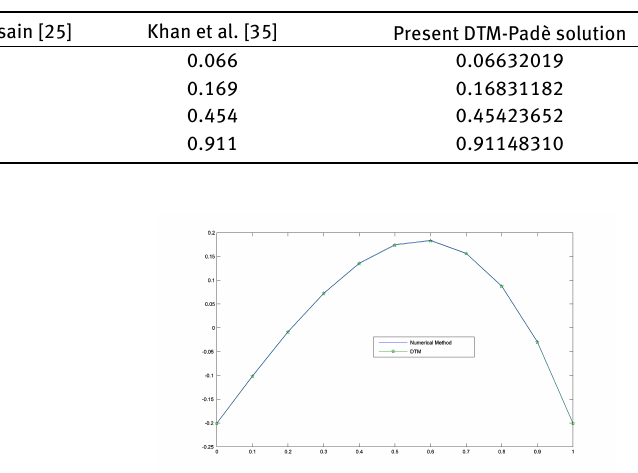
Table 4: Comparison of the local Nusselt number − θ ′ (0) when λ = 0 and all the nanoparticles concentration parameters as β 1 = β 2 = N t =